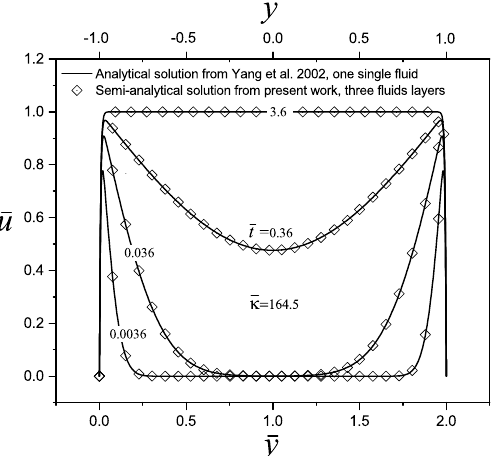
Figure 2. Dimensionless velocity profiles of an electroosmotic flow obtained by Yang et al. [10] with n = 1, against the results of the present investigation with three fluid layers, n = 3 ( ¯ y 1 = 2/3 and ¯ y 2 = 4/3). The other parameters are ¯ ρ n = ¯ η n = ¯ (cid:101) n = 1, and ∆ ¯ ψ n =